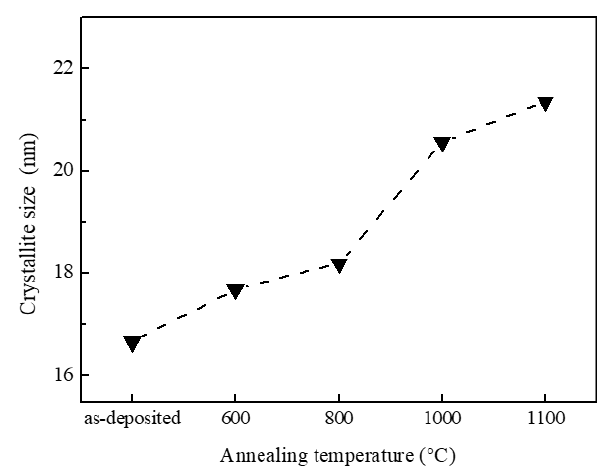
Figure 2. The (101) orientation crystallite sizes of as-deposited TiO 2 films and TiO 2 films after annealing.